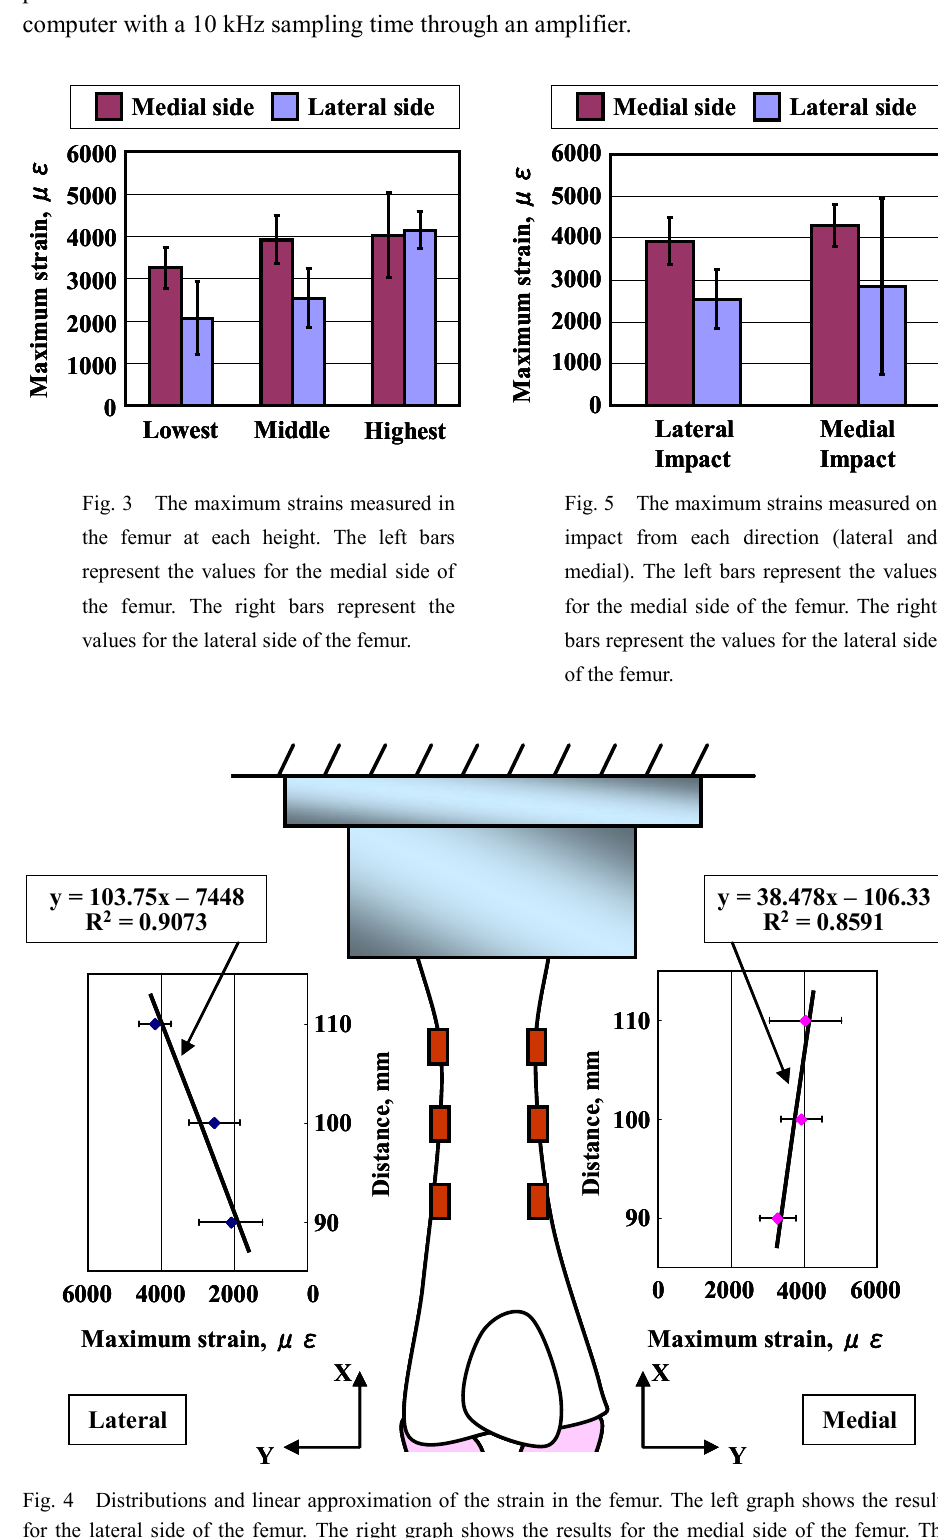
Fig. 4 Distributions and linear approximation of the strain in the femur. The left graph shows the results for the lateral side of the femur. The right graph shows the results for the medial side of the femur. The x-axis represents the distance from the knee joint level. The y-axis represents the maximum strain at each height.